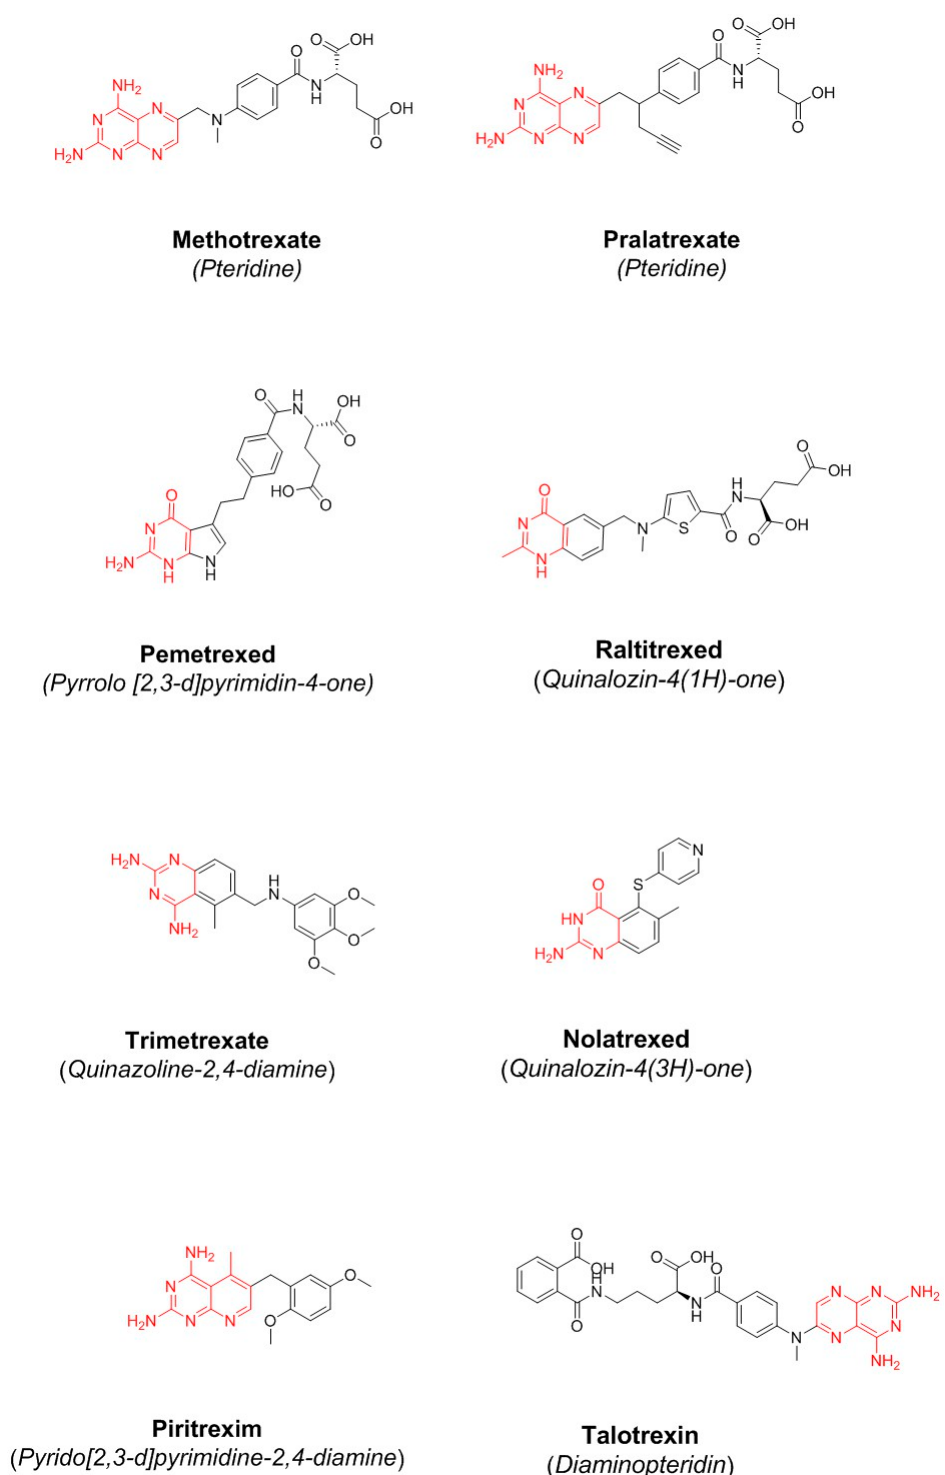
Figure 4. Chemical structure of some classical and non-classical antifolates.